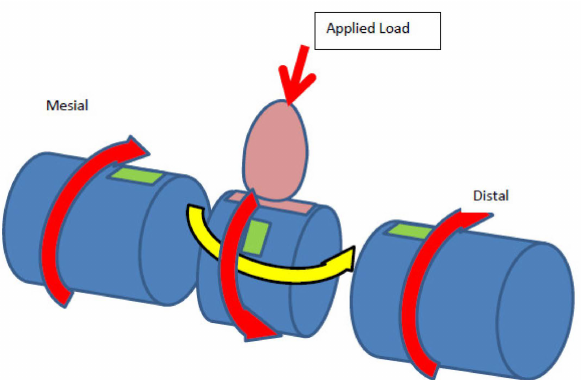
Figure 11. The remaining gauges allowed an overall picture of torsional stresses in the body of the mandible. The horizontally (mesial-distal) oriented rotational moment caused by the inadvertent off-axial load application, as seen from the buccal aspect, has been included as a horizontally oriented torsional load (yellow arrow). In this study, this rotation has been defined as